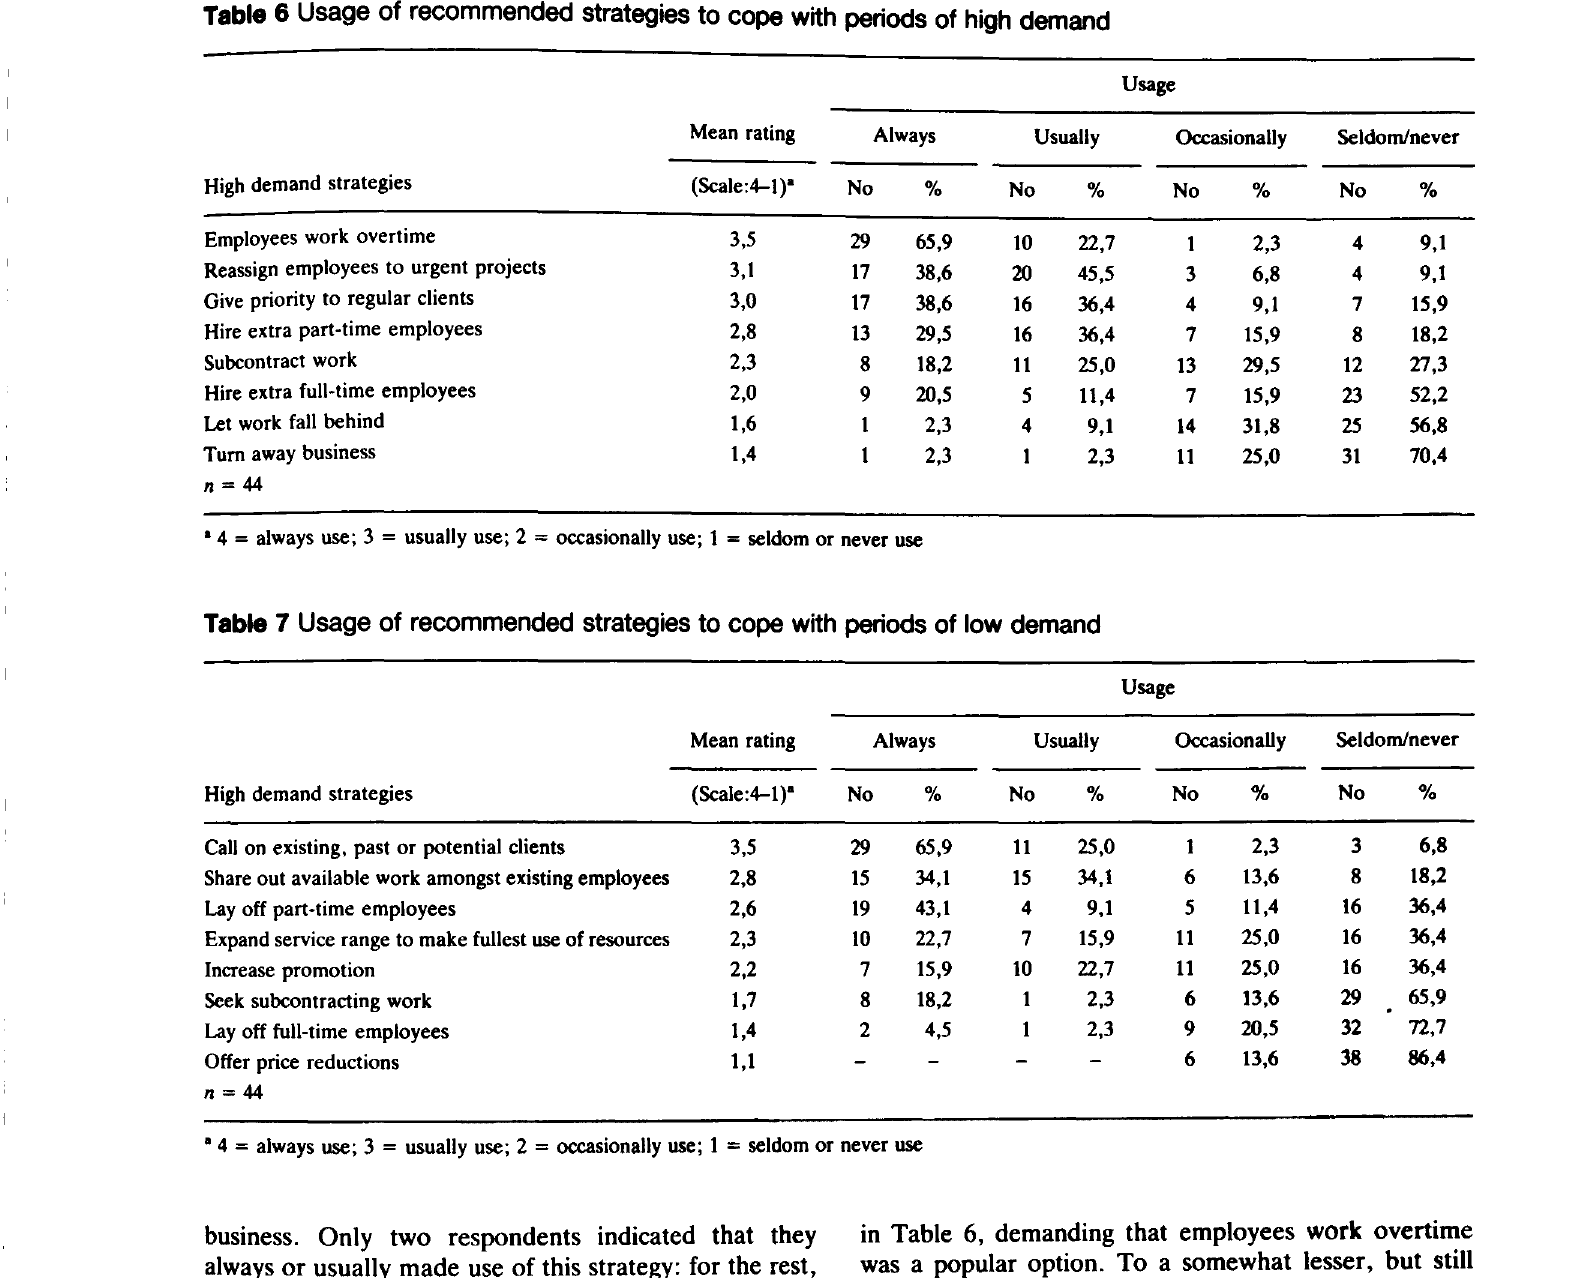
Table 6 Usage of recommended strategies to cope with periods of high demand High demand strategies